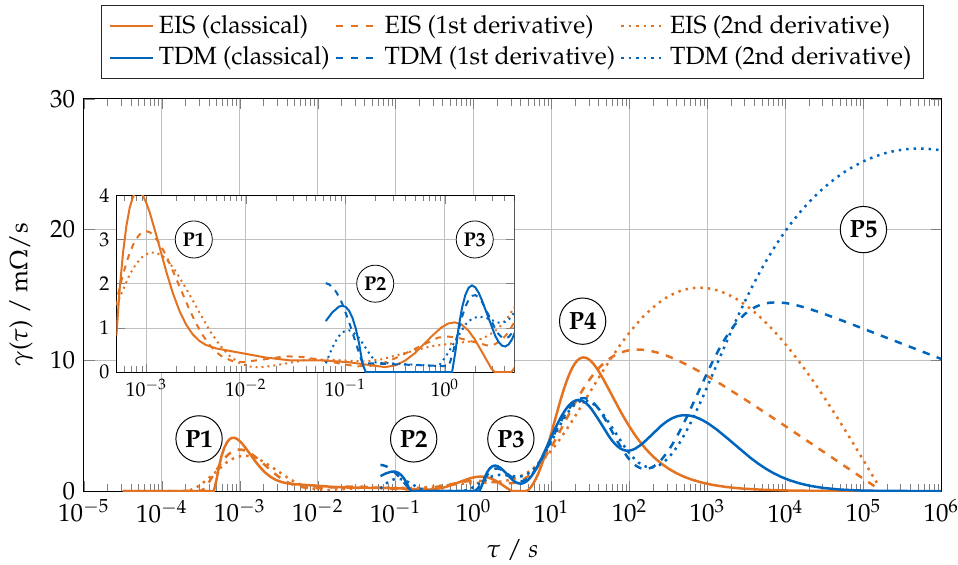
Figure 3. DRT calculated from EIS and TDM at 50% SOC for different regularization terms, respec- tively. The EIS-DRT reveals the four processes P1–P4 and the TDM-DRT reveals the four processes